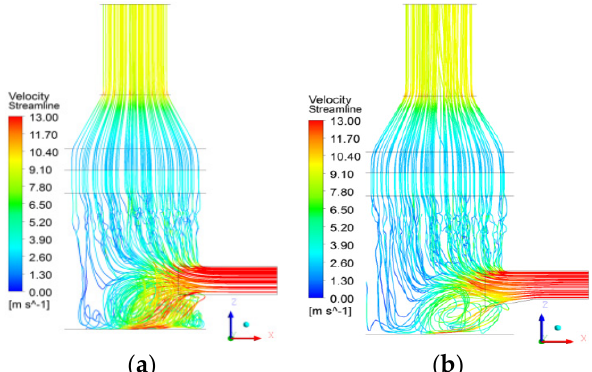
Figure 7. The gas phase streamlines diagram with and without flue baffle; ( a ) d = 0 m; ( b ) d = 0.5 m.